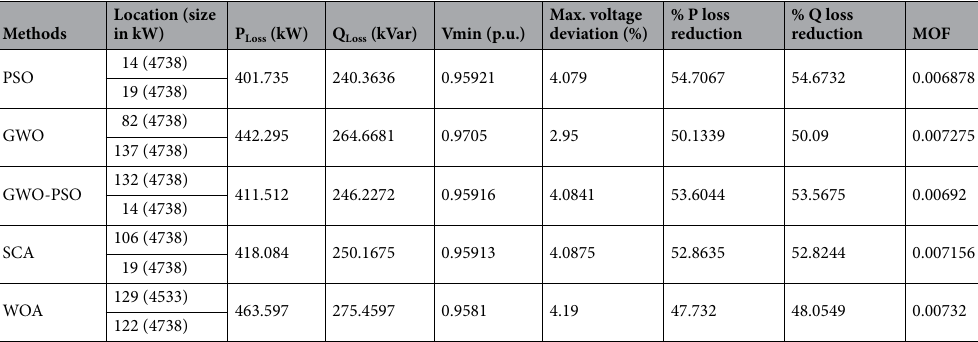
Table 4. Performance measurement after 2-DG integration with different algorithms.